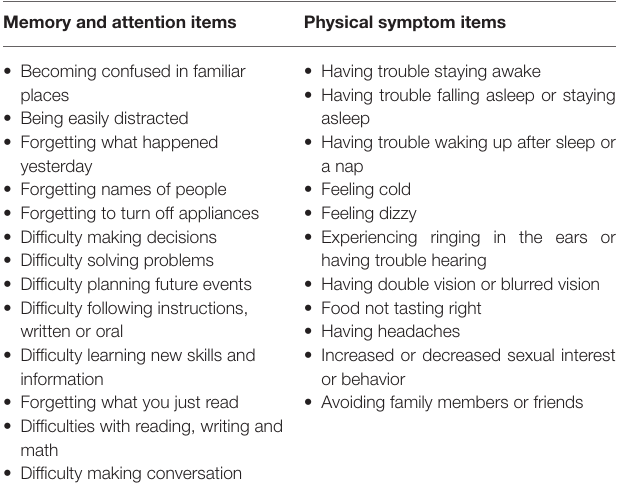
TABLE 3 | Example symptom items factorized together under memory-attention and physical subscales of BISQ. Memory and attention